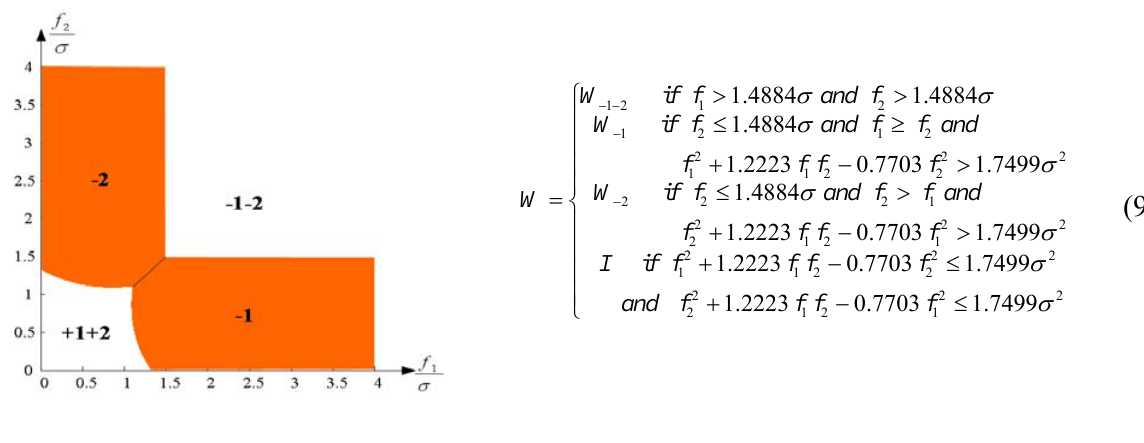
Figure 13. Accommodation rule for 1 st and 3 rd faulty sensors for configuration 2.